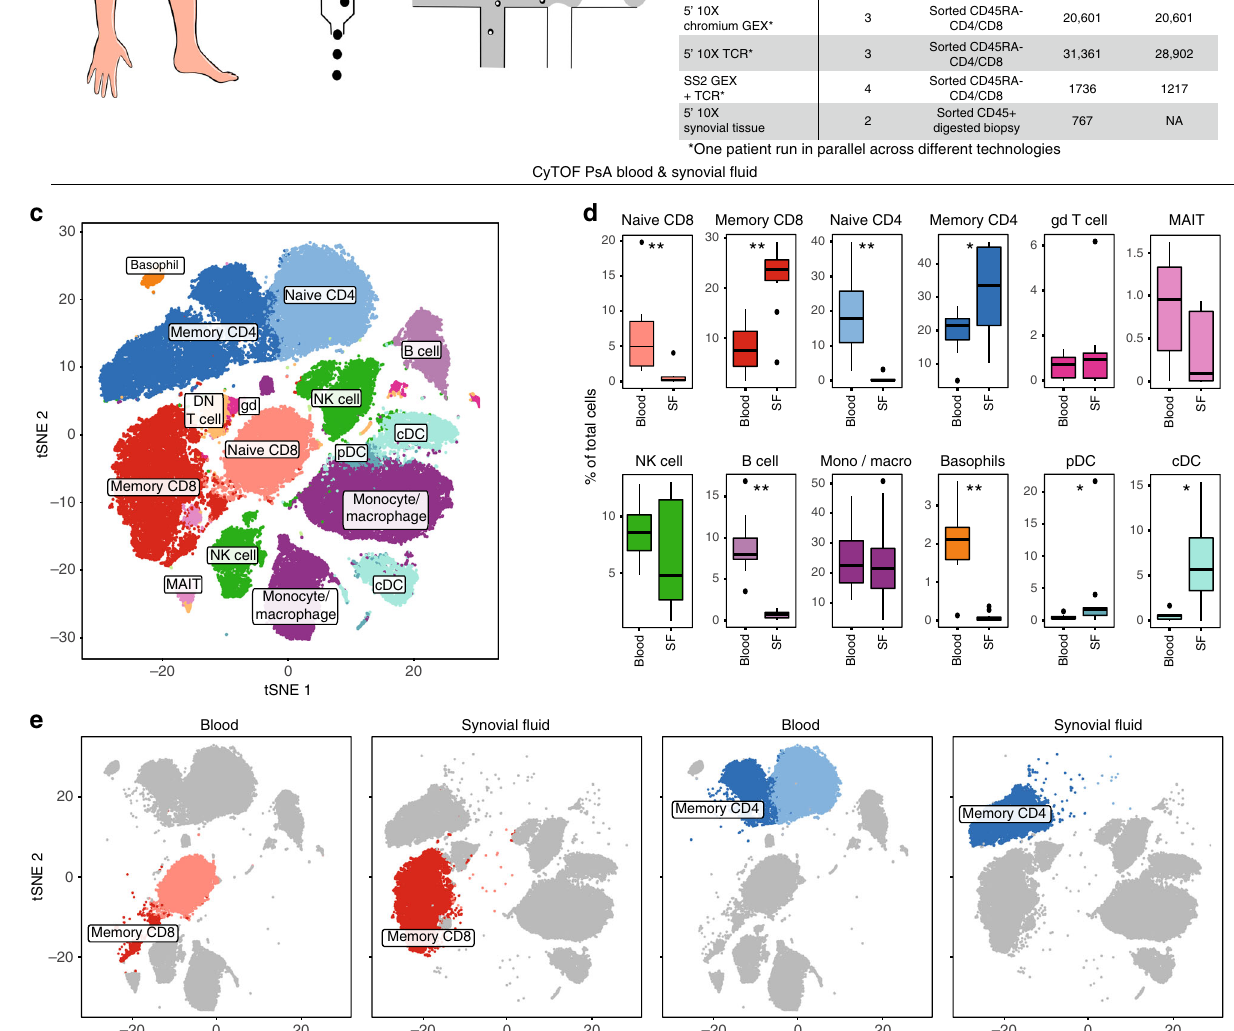
Fig. 1 Landscape of synovial leukocyte populations in psoriatic arthritis. a Overview of experimental design. b Cell numbers used in each of the experimental techniques . c Representative map of CyTOF clusters derived from one PsA patient ’ s matched peripheral blood and synovial fl uid cells using t -SNE. d Boxplots showing cluster frequencies within blood and synovial fl uid (SF) from ten independent experiments. All replication attempts were successful. For all boxplots, the upper whisker extends to the largest value, maximally 1.5 × IQR from the 75th centile, and the lower whisker extends to the smallest value, 1.5× IQR from the 25th centile. The junctions of whisker and box (hinge) represent the 25th and 75th centiles, while median is indicated by the central line. Outlier values are plotted individually beyond the whiskers. Two-sided paired t test with Bonferroni correction. n = 10 (* = p < 0.05, ** = p < 0.01, *** = p < 0.001). Exact p value naive CD8, memory CD8, naive CD4, B cells and basophils = 0.0059, memory CD4 = 0.025, pDC = 0.032 and cDC = 0.013. e Representative map of CyTOF clusters derived from one PsA patient, divided according to tissue of origin and highlighting memory CD8 (dark red) and memory CD4 (dark blue) T cells. Source data are provided as a Source Data fi